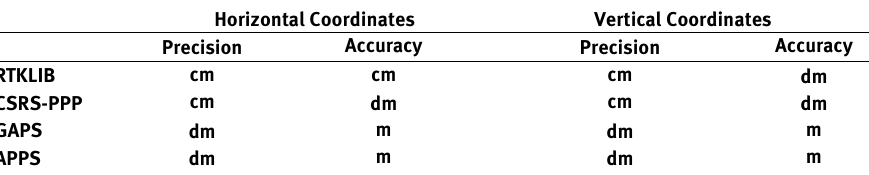
Table 9. Precision and accuracy of the software used.